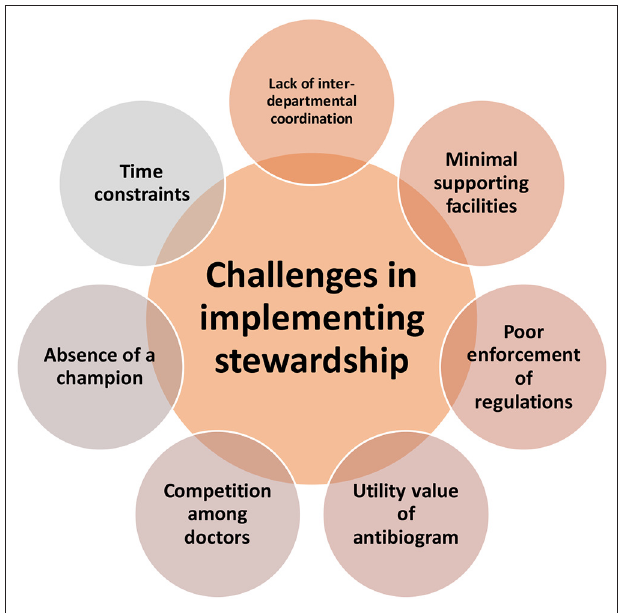
FIGURE 3 | Challenges in implementing a stewardship